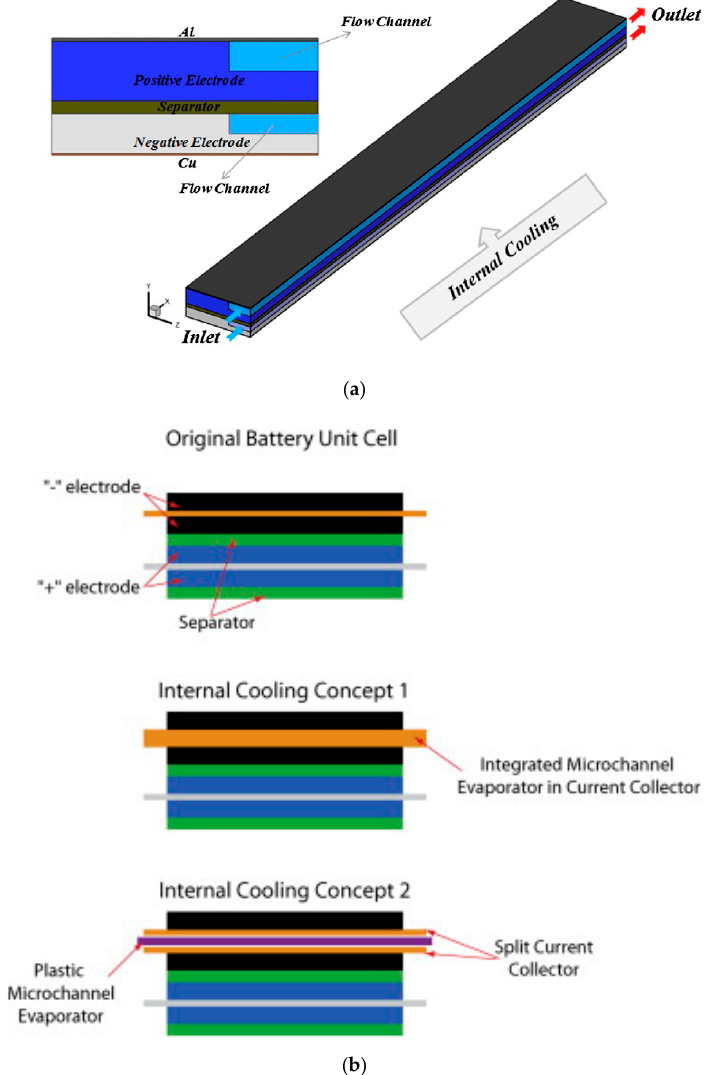
Figure 18. Internal thermal management: ( a ) internal cooling by micro-channel in electrode, adopted from Ref. [237]; ( b ) internal cooling by micro-channel evaporator in current collector, adopted from Ref. [238].